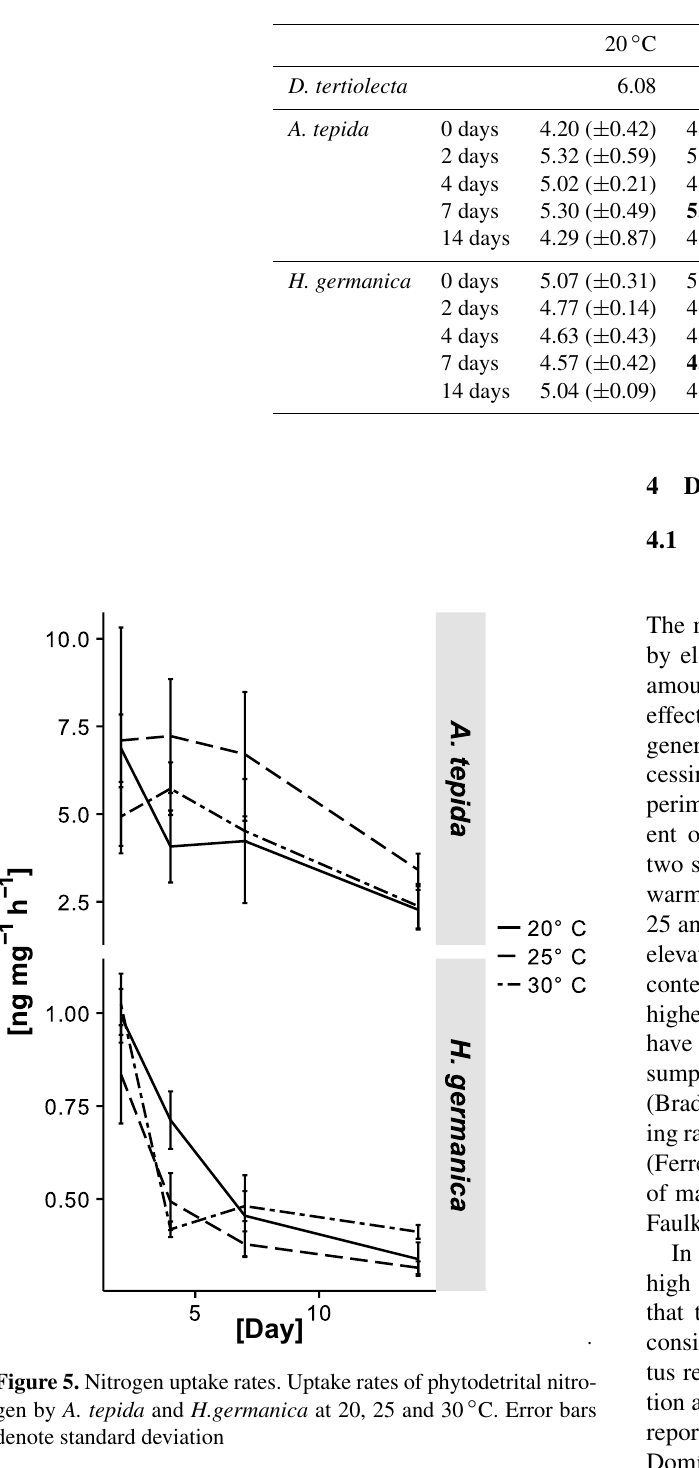
Table 4. C:N ratios of algae and foraminiferal cytoplasm. Brackets contain standard deviation. Ratios in bold letters denote differences of C:N between A. tepida and H. germanica . Welch’s t test, p < 0.050.